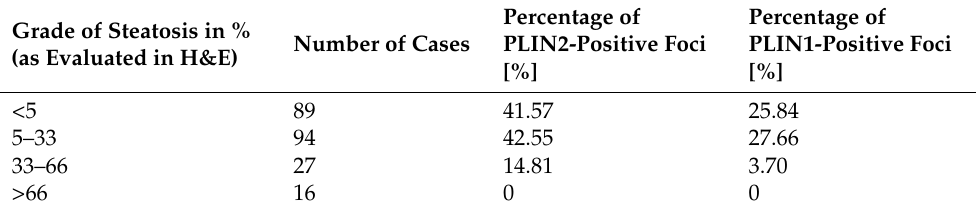
Table 2. Grade of steatosis and percentage of steatotic foci in chronic hepatitis